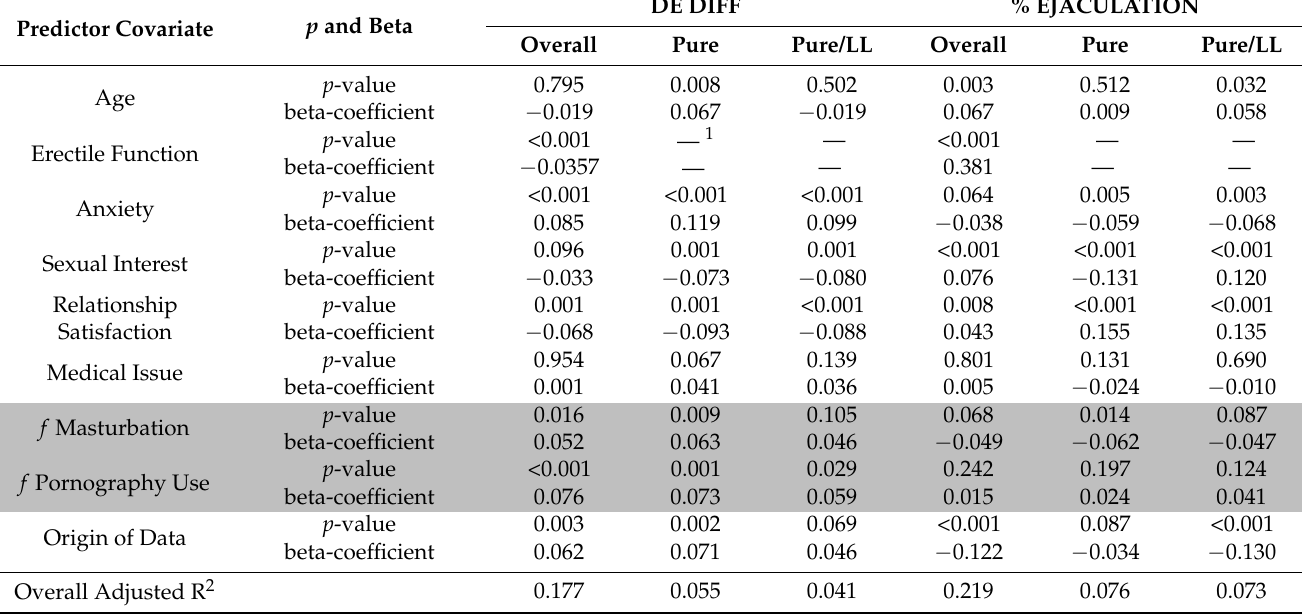
Table 3. Results of regression analysis using difficulty reaching orgasm (DE DIFF) and percent of time reaching ejaculation (%EJACULATION) as outcome variables when DE was unrestricted (Overall), was restricted by removing all men with ED (Pure DE), or was restricted by removing all men with ED or acquired DE (Pure/Lifelong (LL) DE). Masturbation frequency and pornography use frequency are highlighted by darker gray